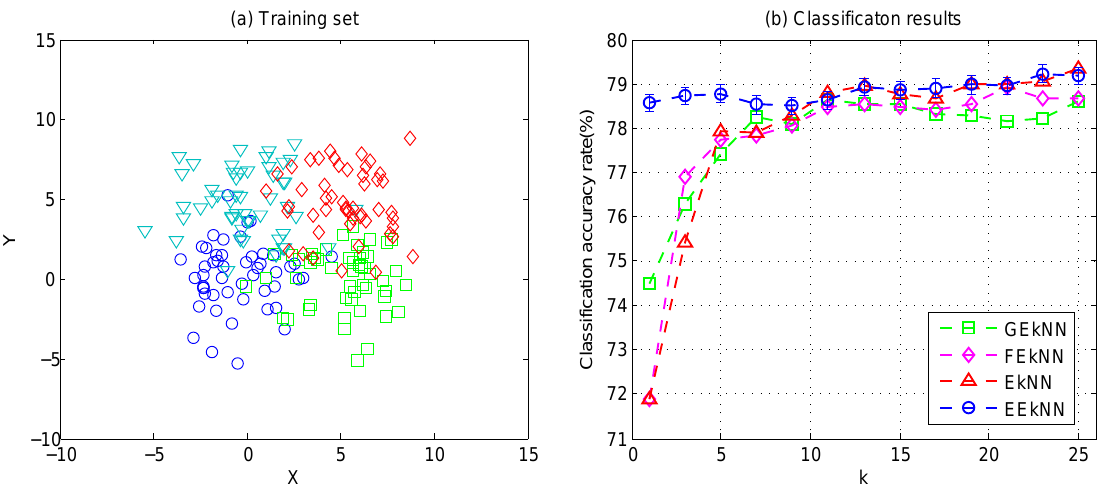
Figure 5. Training set and classification results for Case 1 with imprecision ratio ρ = 33%.